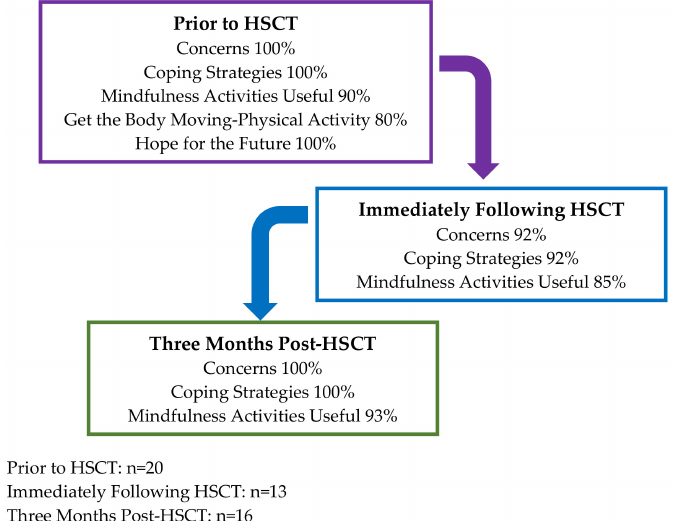
Figure 1. Percentage of AYA’s who stated common themes in qualitative